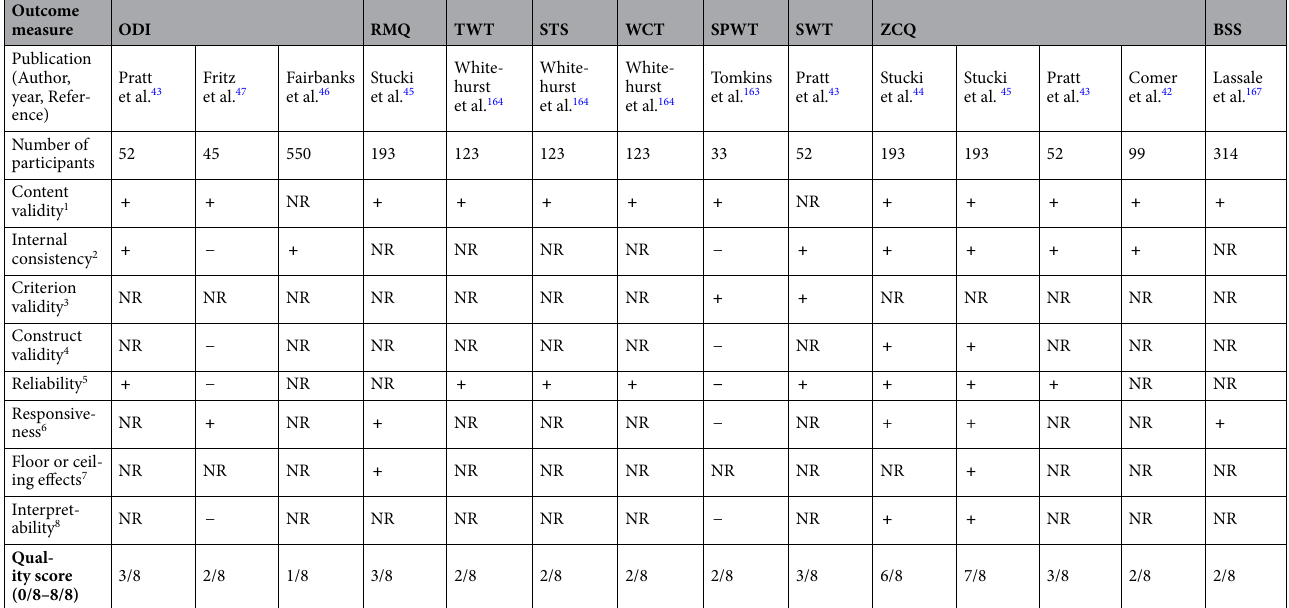
Table 4. Summary and quality of validation studies. Interpretation (COSMIN Checklist) 8 . + , domain fulfilled (very good or adequately addressed); NA, not applicable; NR, not reported; − domain was not fulfilled. 1 Content validity: clear description of the measurement aim, the target population, widely accepted or appropriate methods and concepts were used, the item selection, and the investigators OR experts involved in item selection. Number of patients adequate (very good ≥ 50, adequate 30–49). 2 Internal consistency: Scale